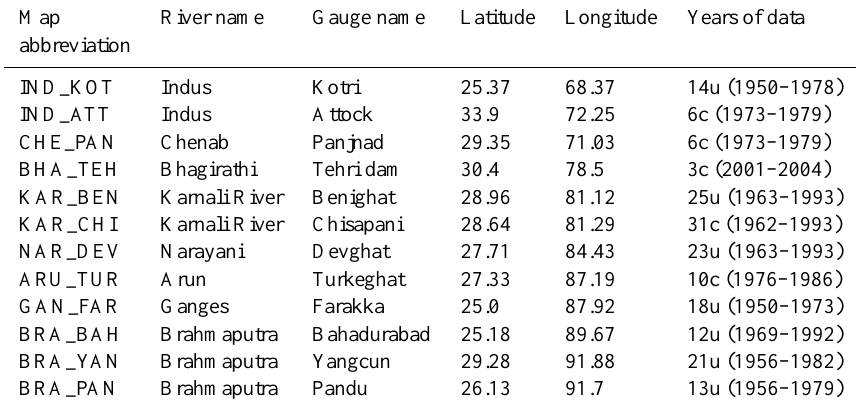
Table 1. Table listing the rivers and gauges (including their location) used in this analysis; all the observations shown here are from GRDC. The abbreviations used in Fig. 2 are given in column one. The years of data column includes the number of years that data is available since 1950 with “c” to denote where data are continuous and “u” to show where the data are available for that number of years but not as a continuous data